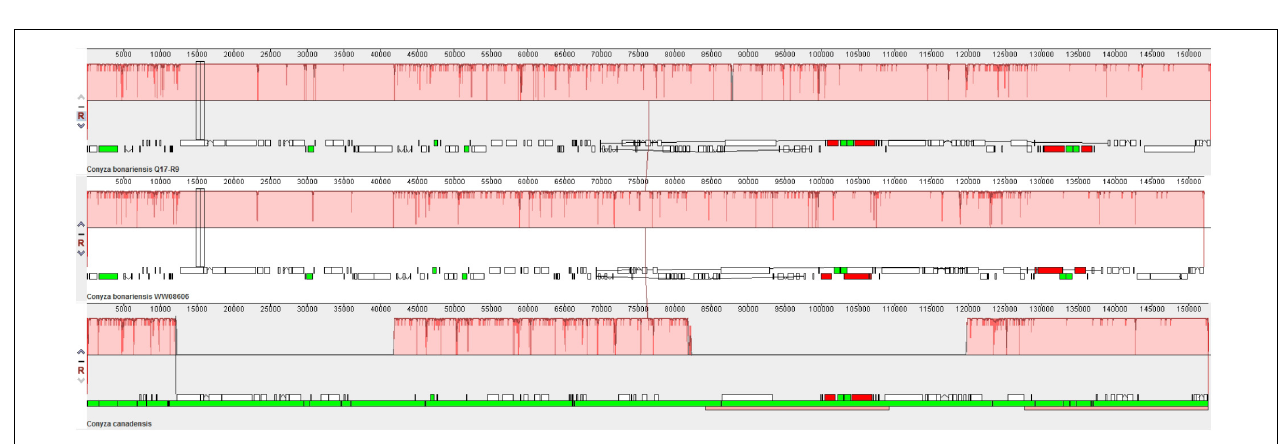
FIGURE 2 | Alignment of three Conyza cp genomes in MAUVE. The identified locally collinear blocks (LCBs) for each genome are labeled with pink color. The gene order of each cp genome is shown below the LCBs.